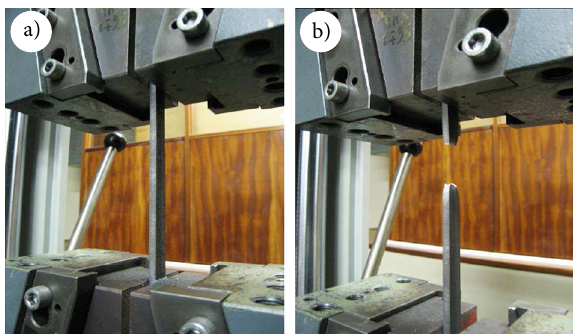
Fig. 2. Tensile coupons test: a) Tension test specimen; b) Tension specimen at end of test